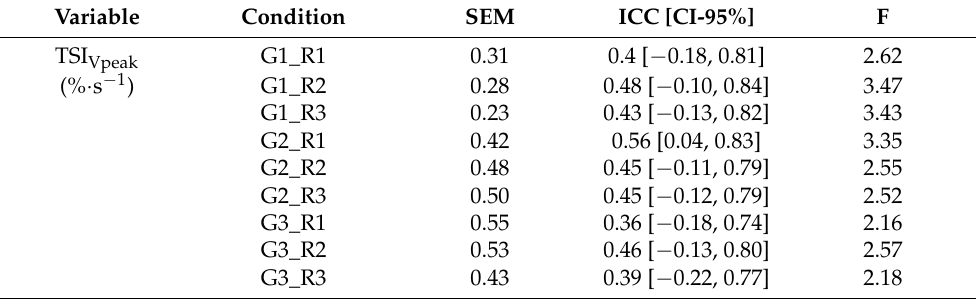
Table 14. Between sessions reliability for Vpeak of reoxygenation rate.